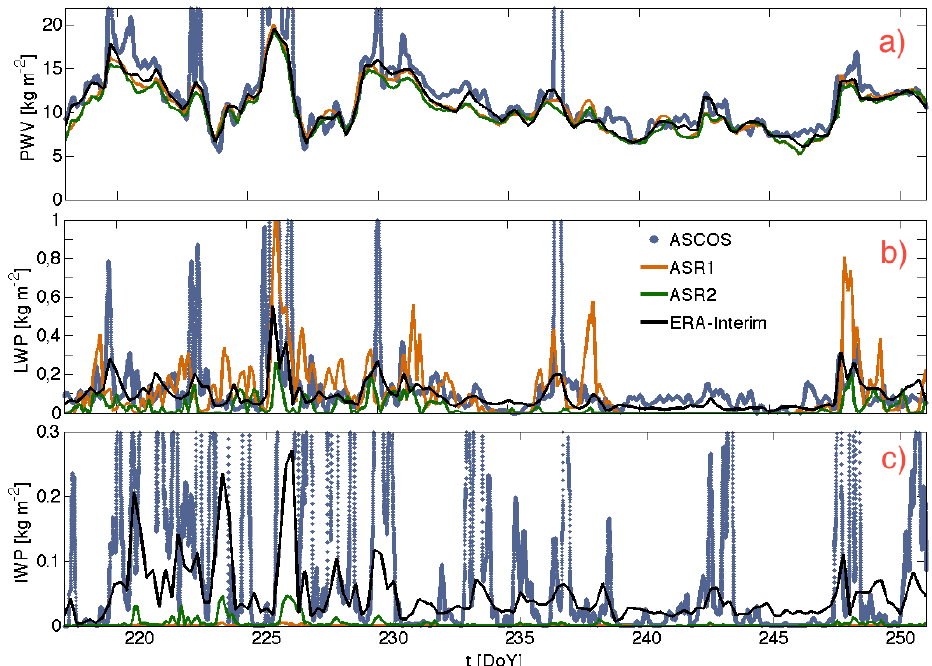
Fig. 8. Time series of integrated water properties showing (a) precipitable water vapor (PWV), (b) liquid water path (LWP) and (c) ice water path (IWP), all in kgm − 2 , as a function of the time in day of year (DoY) 2008. Note that the observations in (a–b) are from the dual-channel microwave radiometer, while the IWP (c) observations are estimated using the